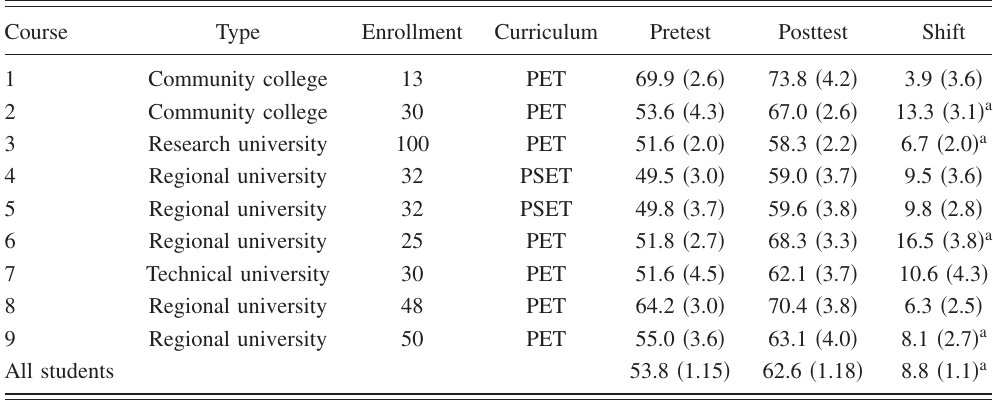
TABLE III. Overall favorable scores on CLASS (cid:1) standard error in parentheses (cid:2)